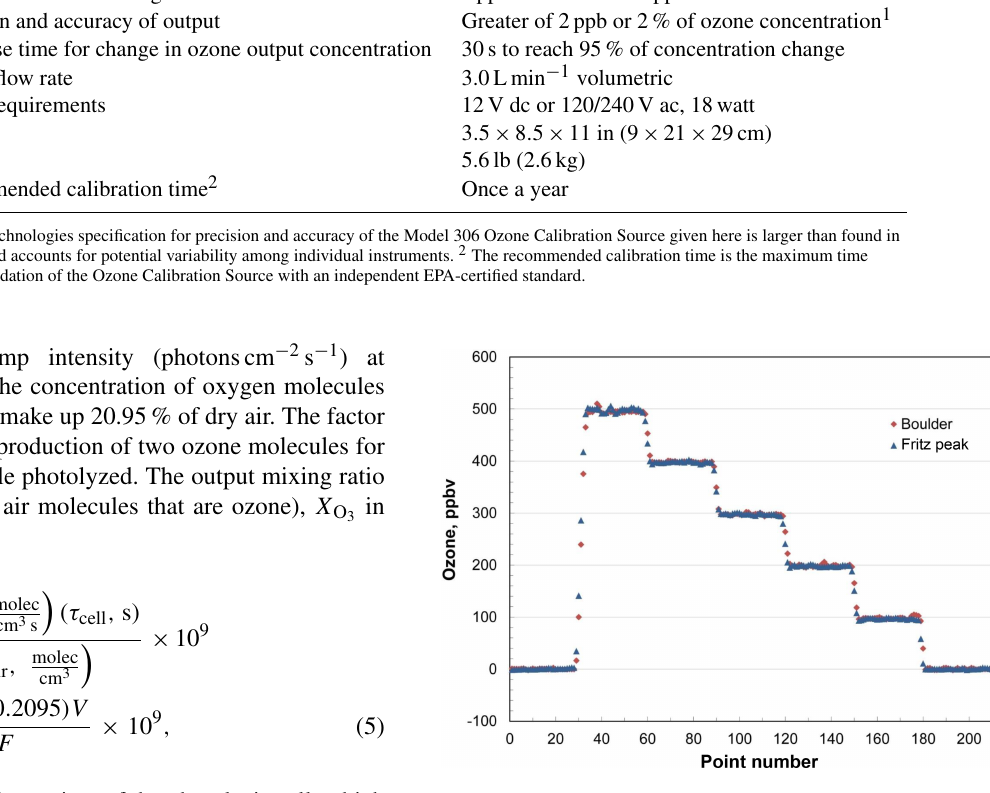
Figure 5. Comparison of ozone output mixing ratios in Boul- der, Colorado (5430ft, 1655m altitude) and Fritz Peak (9020ft, 2749m altitude) as measured by a 2B Model 202 Ozone Monitor (30 points =